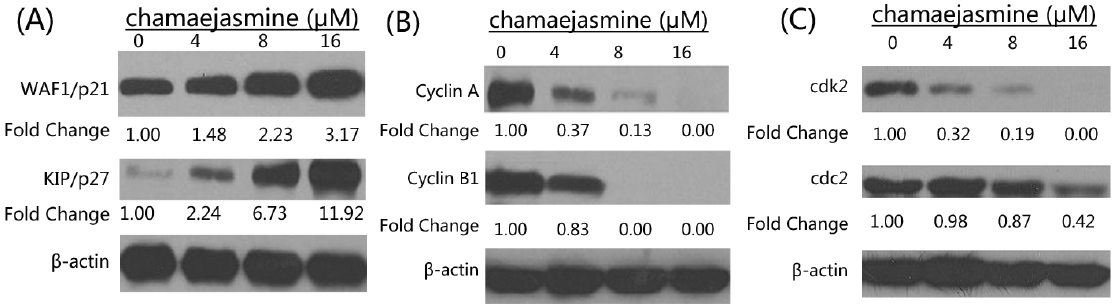
Figure 4. ( A ) Effects of chamaejasmine on protein expression of WAF1/p21 and KIP1/p27 in MDA-MB-231 cells. ( B ) Effects of chamaejasmine on protein expression of cyclin A and cyclin B1 in MDA-MB-231 cells. ( C ) Effects of chamaejasmine on protein